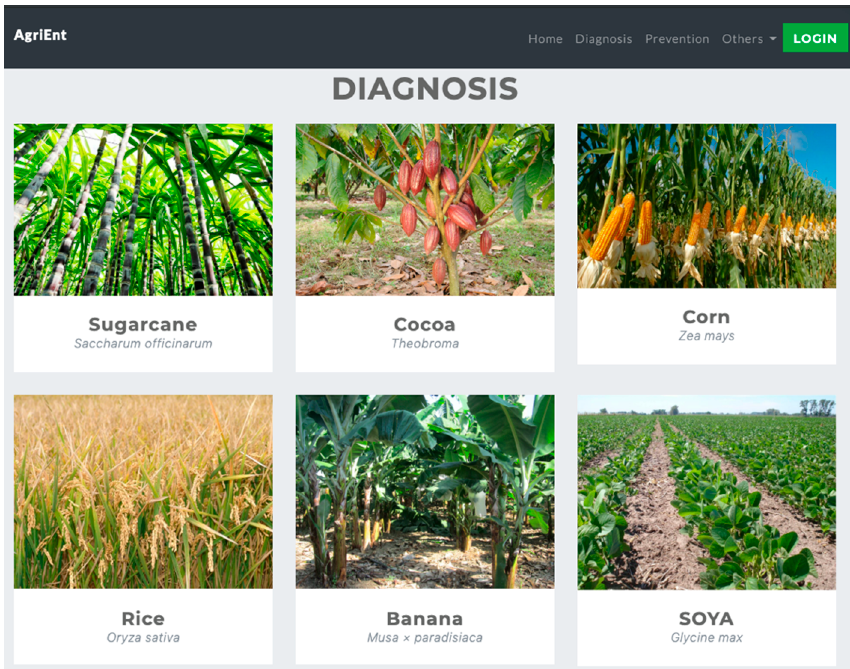
Figure 3. Main user interface of the AgriEnt Web platform.